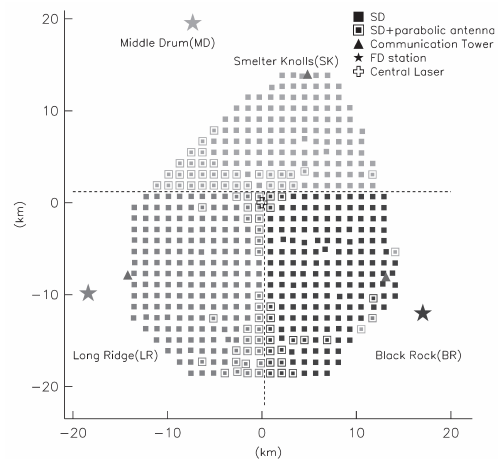
Figure 1: Detector map of TA experiment. Cloud monitor- ing system(CCD camera) is installed at 3 sites of BR, LR and